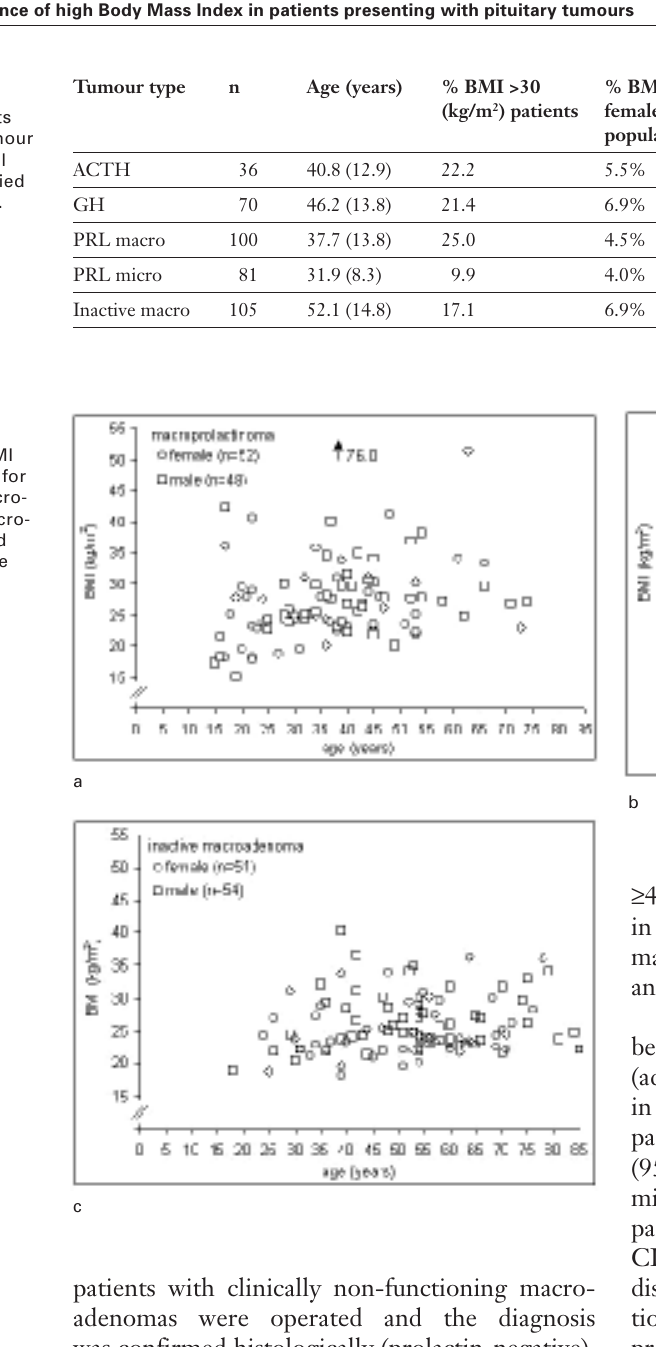
Increased prevalence of high Body Mass Index in patients presenting with pituitary tumours